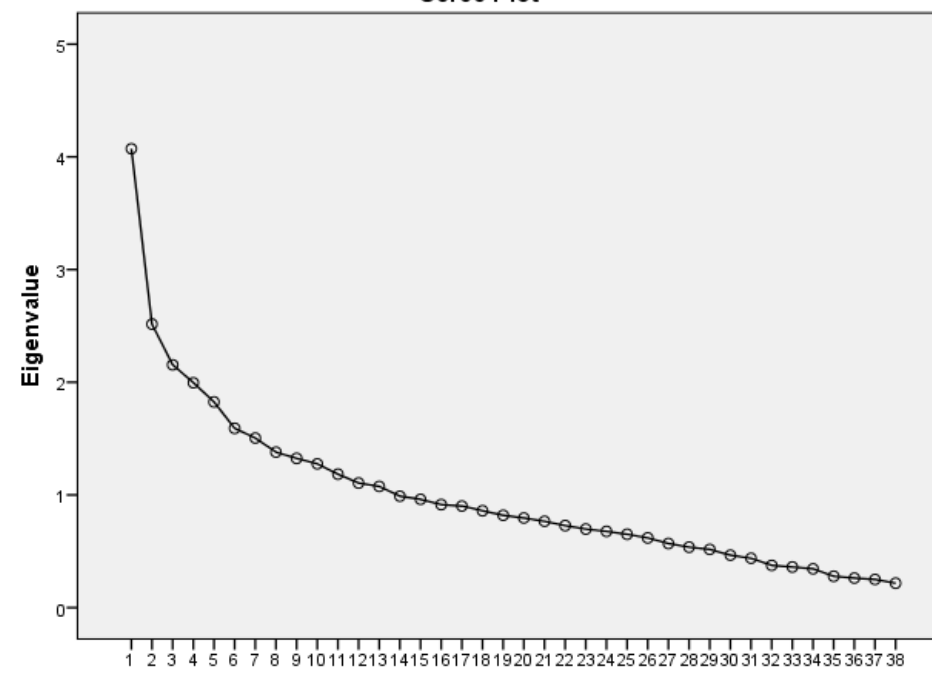
Figure 1. Scree plot from PCA of NNNS and FNASS .